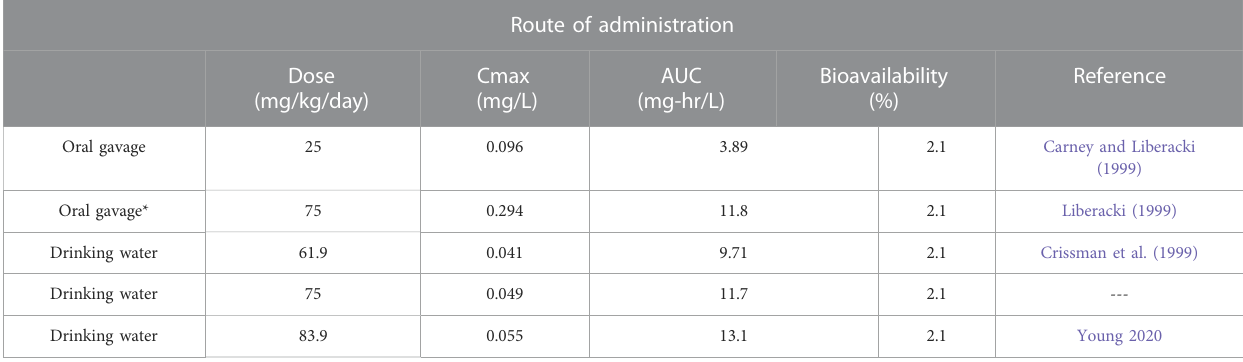
TABLE 3 Predictive Simulations for 28 days of dosing of